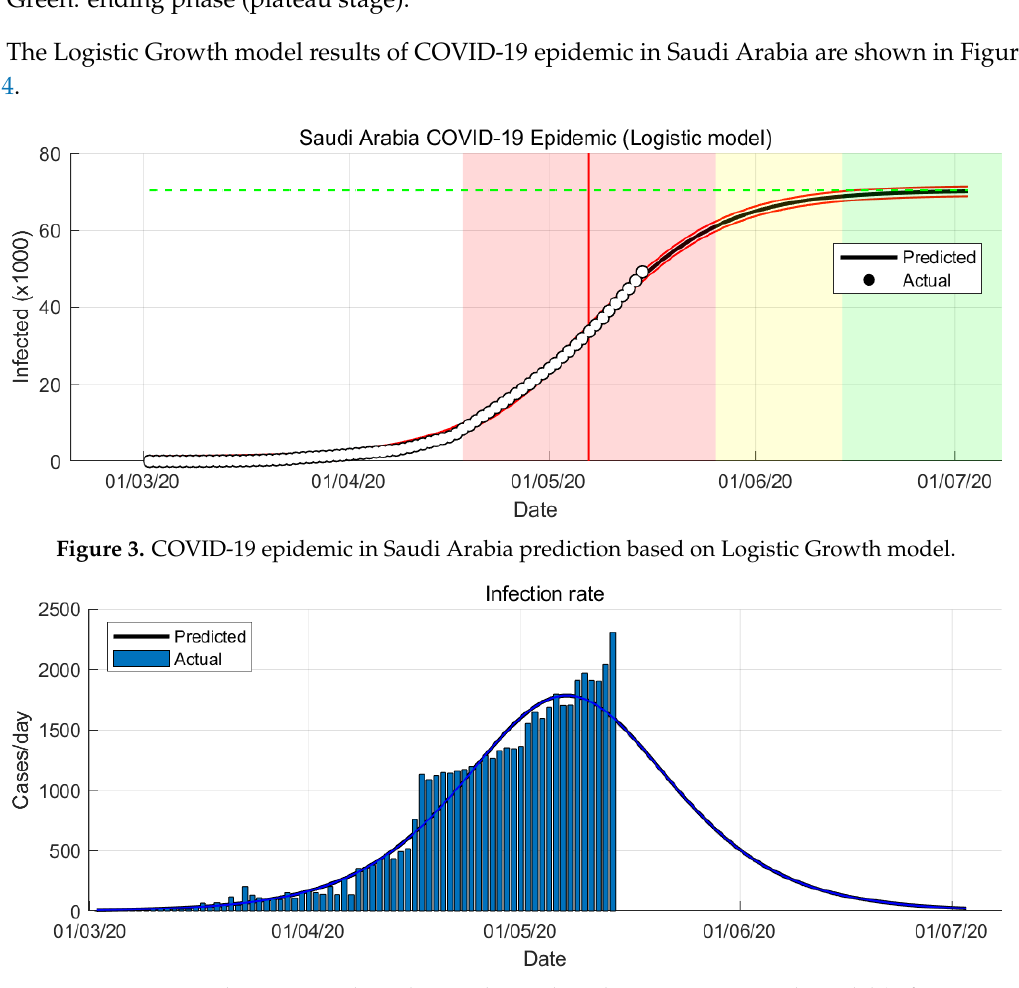
Figure 4. COVID-19 epidemic in Saudi Arabia prediction based on Logistic Growth model (infection